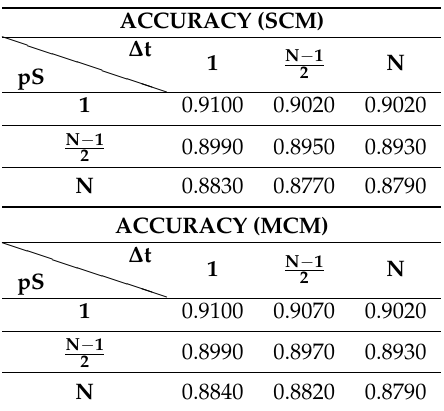
Table 5. Accuracy results for SCM and